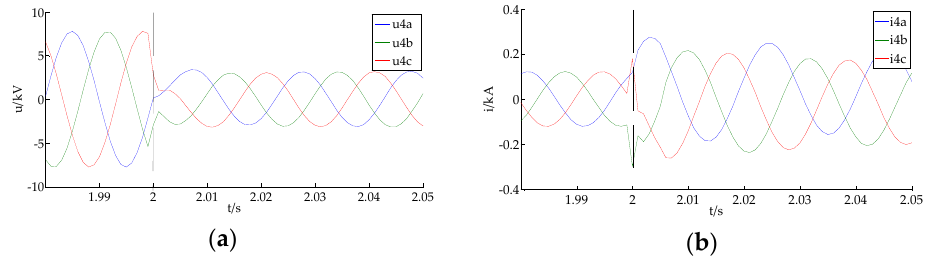
Figure 8. Voltage and current waveforms of Relay 4 during a three-phase fault at k1: ( a ) voltage; ( b ) current.